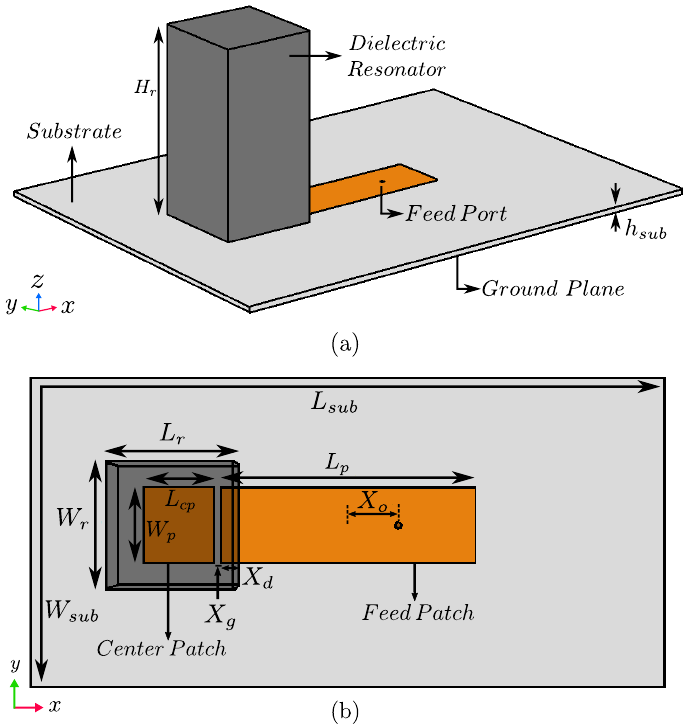
Figure 2. ( a ) 3D view of DRA Unit cell and ( b ) top view with transparent resonator.